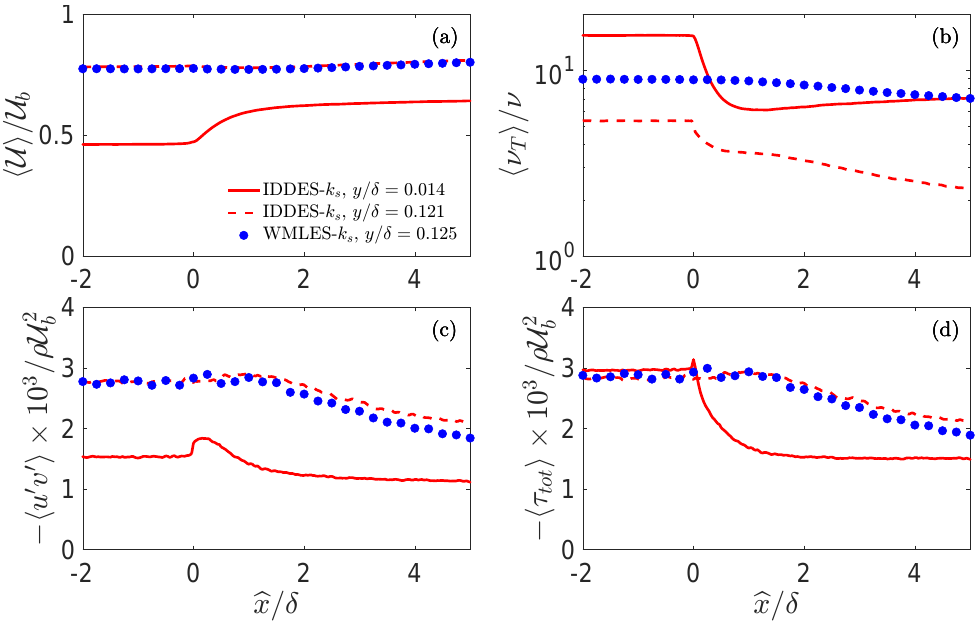
Figure 10. Streamwise development near the rough-to-smooth interface for ( a ) mean velocity, ( b ) eddy viscosity, ( c ) resolved Reynolds shear stress and ( d ) total Reynolds shear